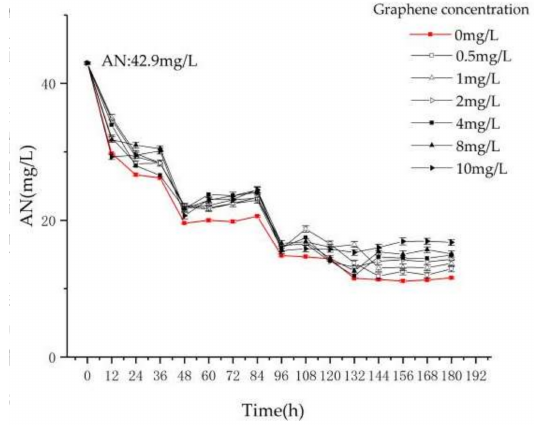
Figure 4. The variation of AN with reaction time and graphene concentration.